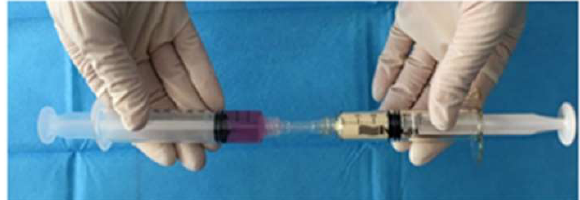
Figure 1. Flowable Wound Matrix-human adipose-derived stem cell (FWM-hASC) mixture